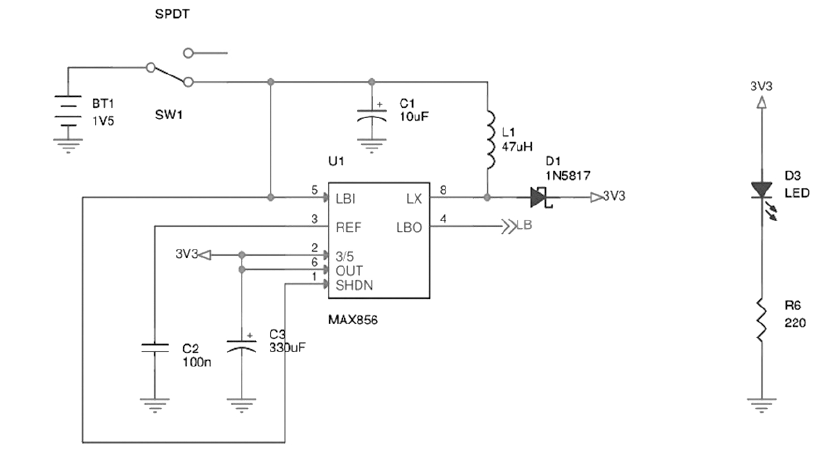
Figure B2. Schematic of power